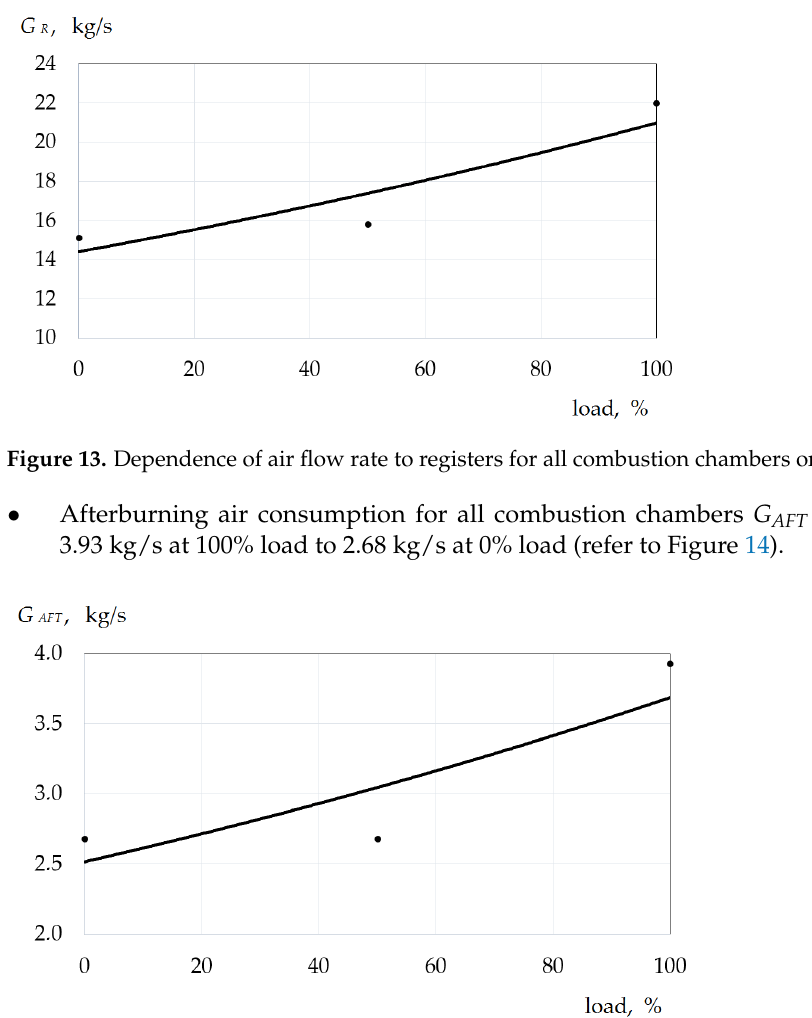
Figure 12. Dependence of primary air flow rate for all combustion chambers on the load value.